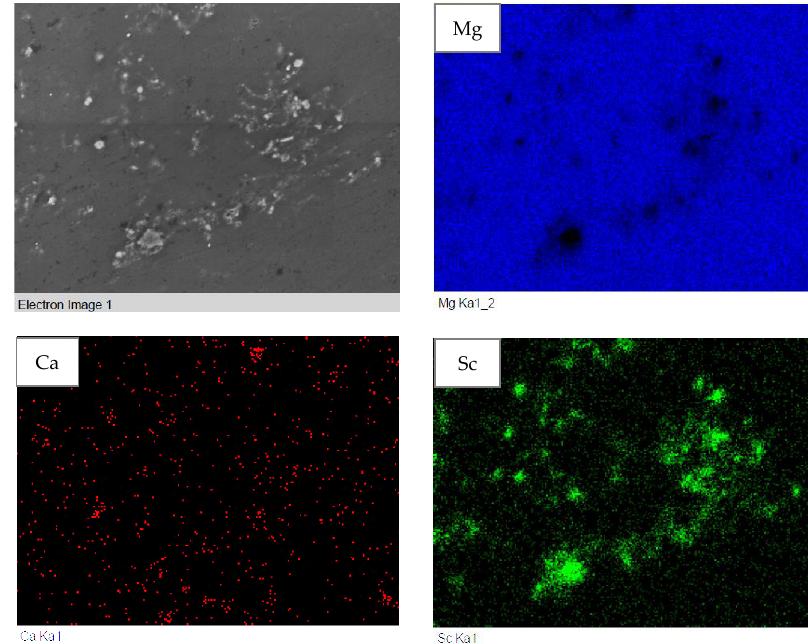
Figure 3. EDX mapping analysis of the Mg1Ca1Sc alloy.